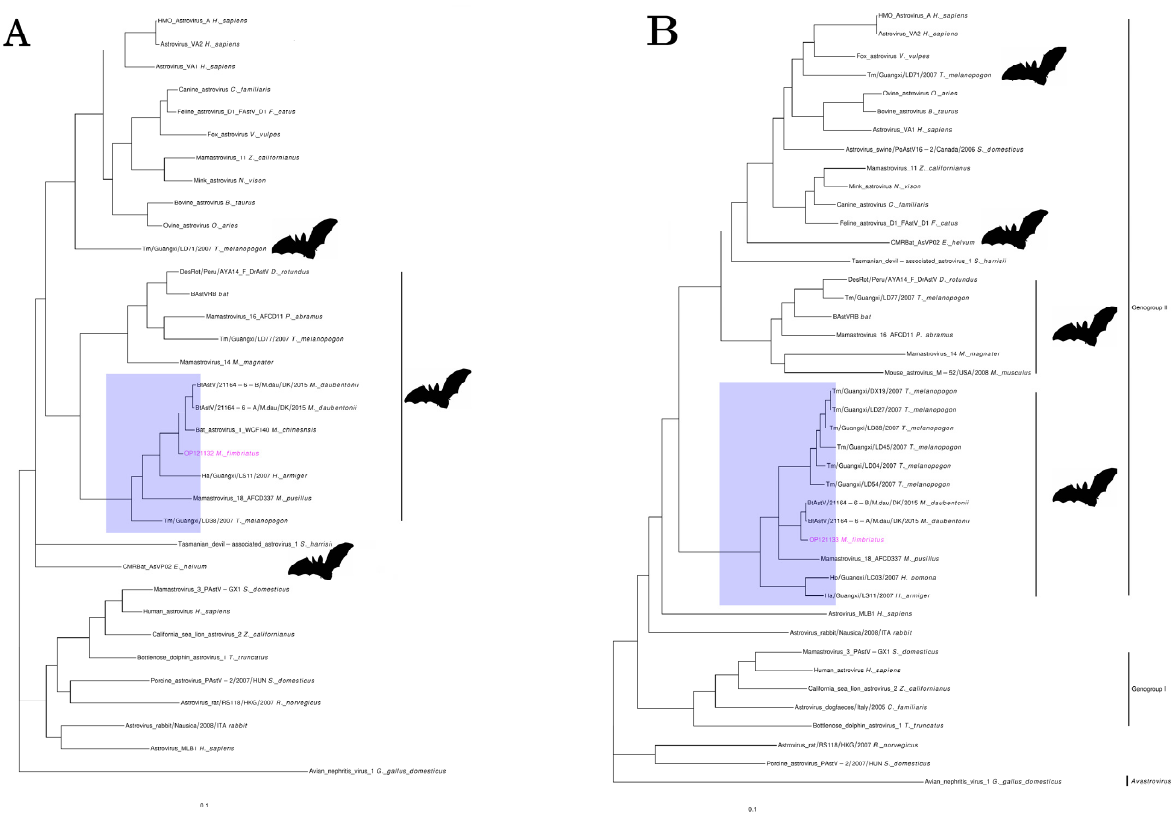
Figure 3. Astrovirus. Phylogenetic trees of representative sequences of astrovirus in ( A ) a 260 a.a region of ORF1b and ( B ) a 564 a.a region of the capsid protein. Both trees were inferred under an LG + I + G model.